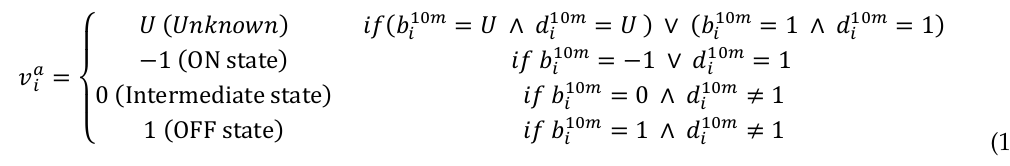
Figure 5. Block diagram of the ON-OFF